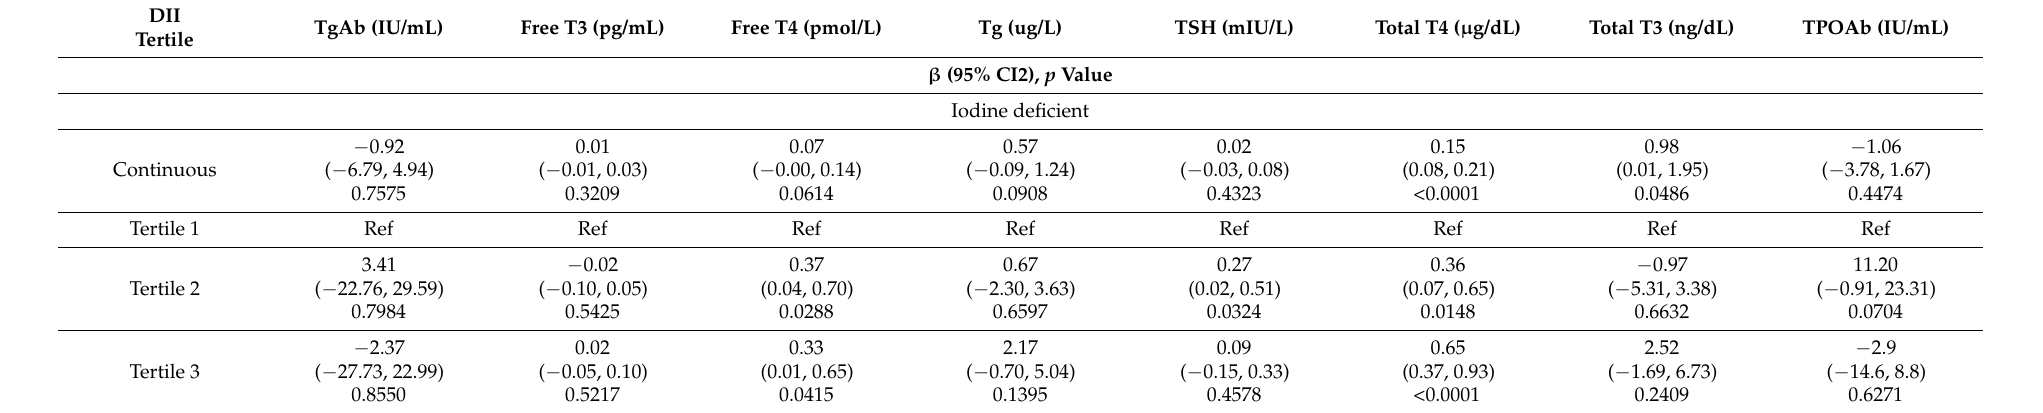
Table 4. Subgroup analysis of the association between DII and thyroid function stratified by UIC groups among adult men in NHANES from 2007 to